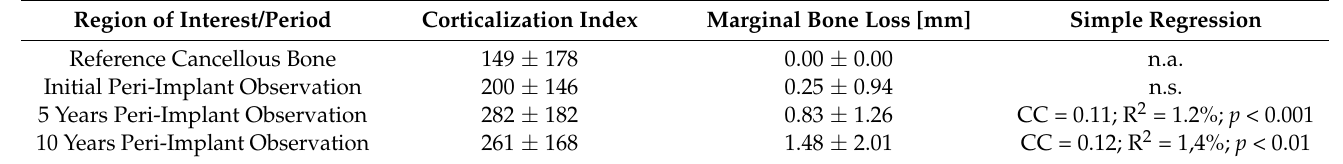
Table 2. The progressive increase in the difference in bone structure of implant-loaded versus reference cancellous bone and the observed relationship with marginal bone loss.